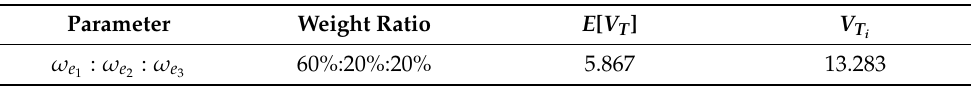
Table 10. Weight for the maximized estimated total project value. Currency: US$ Unit: million